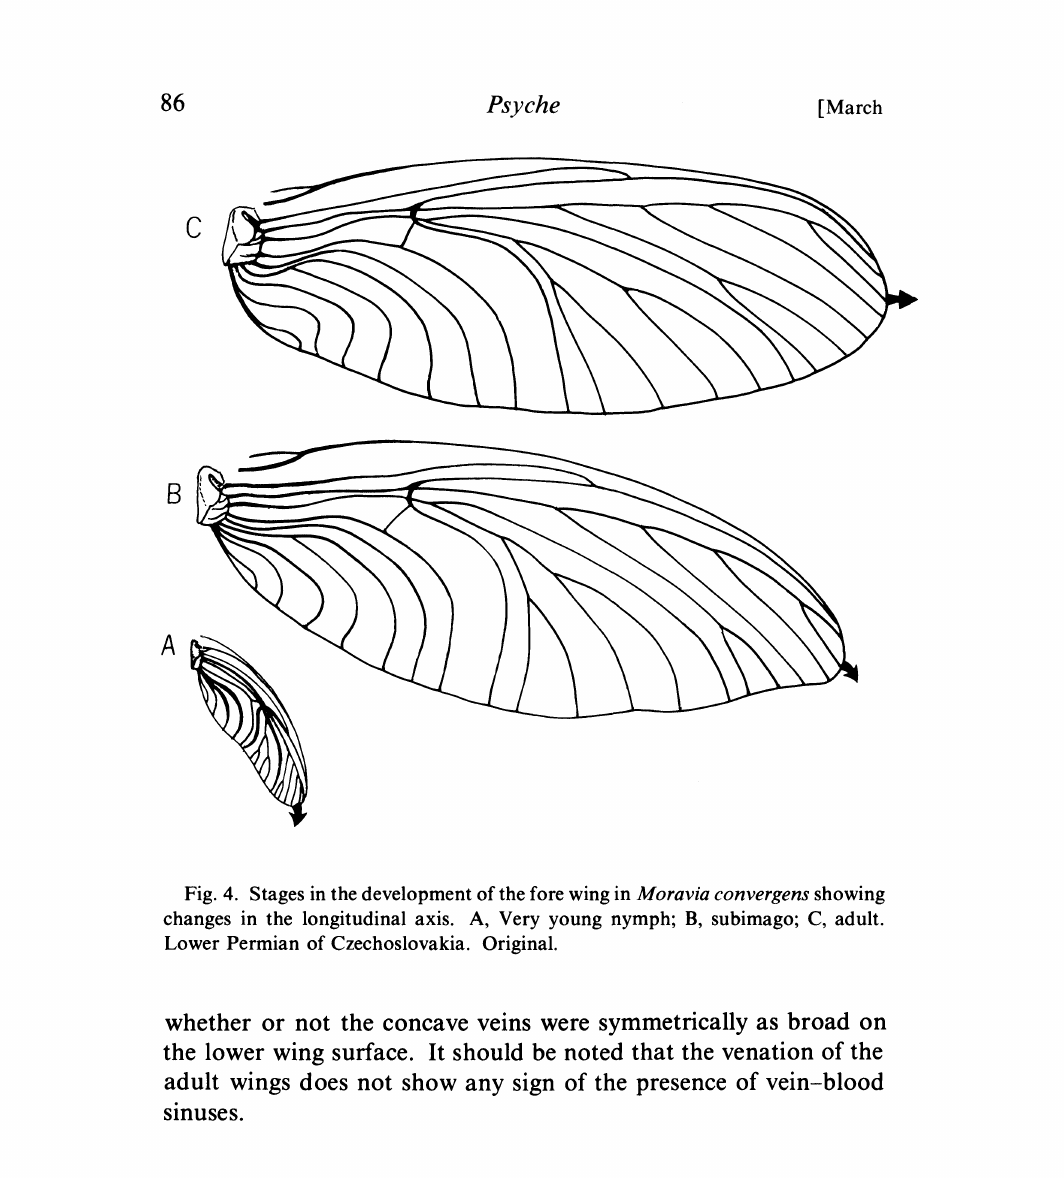
whether or not the concave veins were symmetrically as broad on the lower wing surface. It should be noted that the venation of the adult wings does not show any sign of the presence of vein-blood